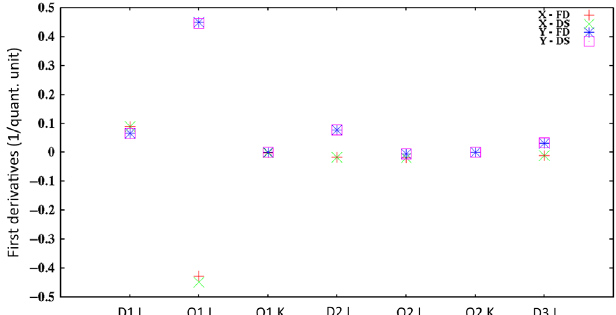
FIG. 2. Derivatives of final horizontal and vertical emittances with respect to seven lattice parameters from the single differ- entiable self-consistent space-charge simulation and from the finite difference approximation to the first